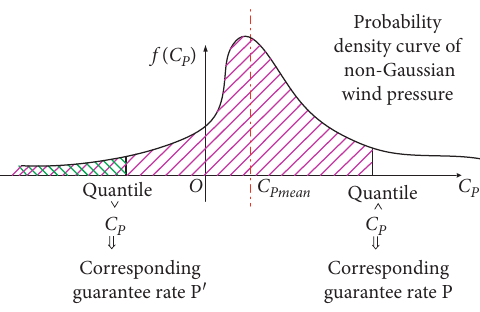
Figure 1: Bilateral guarantee rate